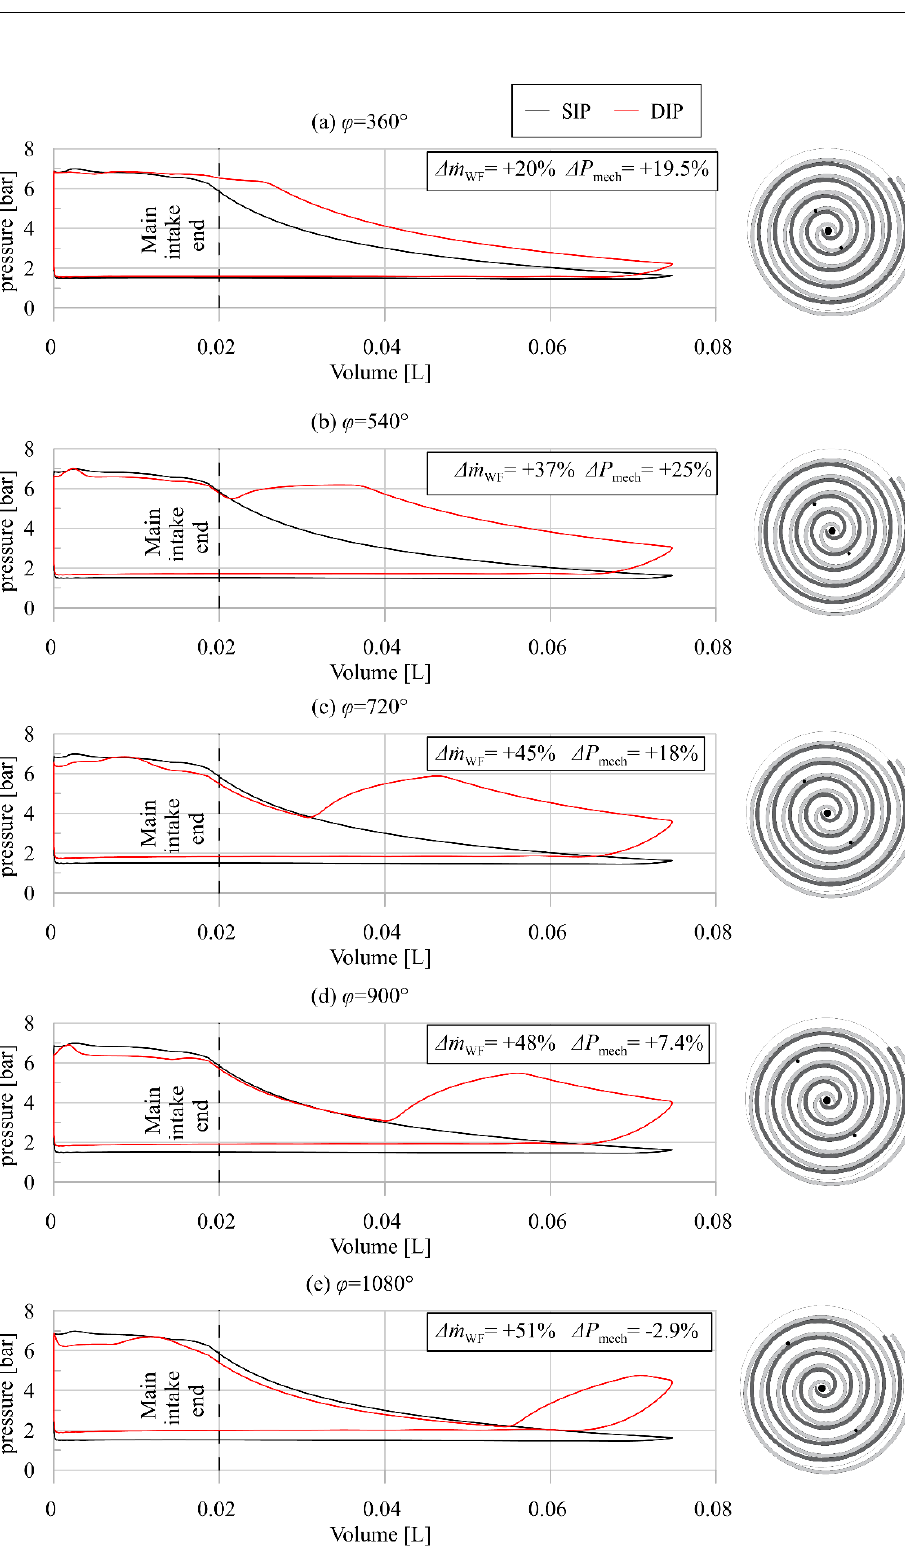
Figure 11. Comparison between the SIP and DIP scroll indicated cycles when φ = 360° ( a ), φ = 540° ( b ), φ = 720° ( c ), φ = 900° ( d ) and φ = 1080° ( e ).